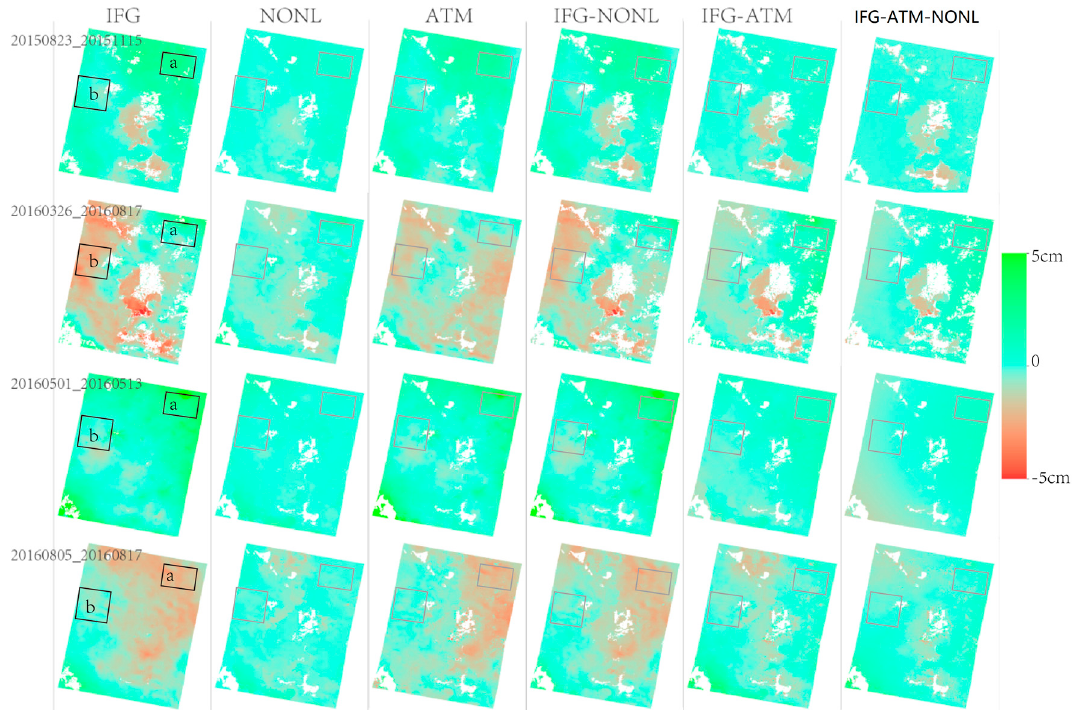
Figure 9. The atmospheric and nonlinear phase analysis of interferograms 20150823_20151115, 20160326_20160817, 20160501_20160513 and 20160805_20160817. The first column marked IFG represents the interferometric phase removed linear displacement; NONL and ATM in the second and third columns are the solved nonlinear phase and atmospheric results with Method III; IFG-NONL and IFG-ATM are the outcomes of subtracting the nonlinear and atmospheric contributions from the interferometric phase, respectively; IFG-ATM-NONL is the residual phase, which has removed nonlinear and atmospheric components from the interferometric phase. Unit: cm. Table 2. Mean and standard deviation of the interferometric phase, nonlinear displacement and atmospheric phase in stable areas a and b. IFG NONL